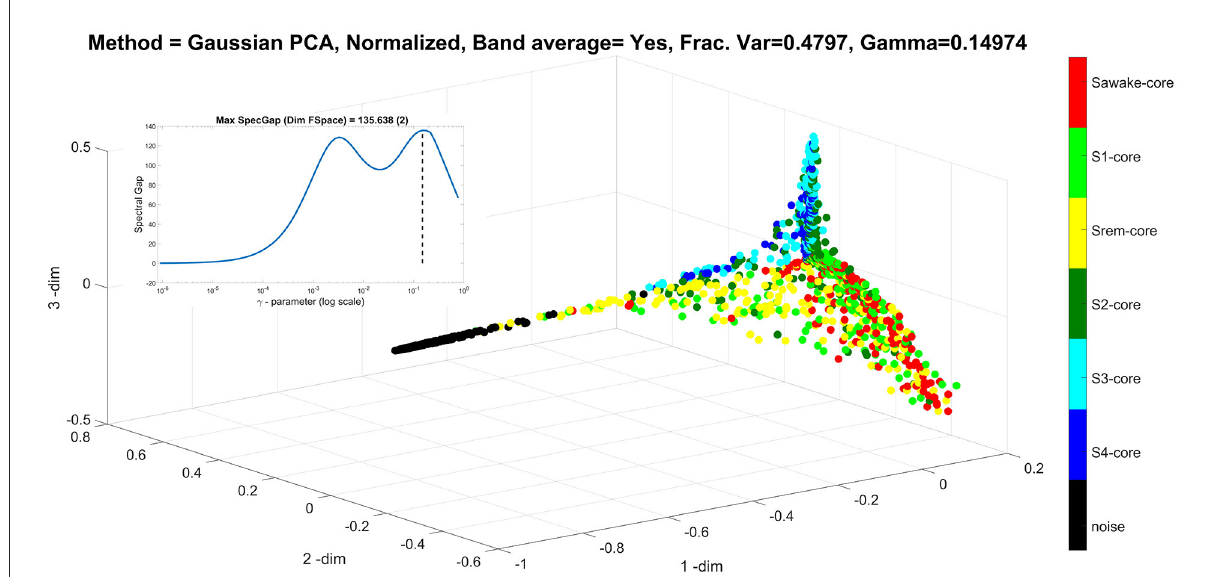
FIGURE6 It is same as Figure 5, but for the value of γ at the second peak, marked by the dash vertical line in the insert (at γ = 0.1497). With this choice of γ , the ellipsoid is lost because the non-linear mapping emphasizes on the distribution of the nodes representing the low amplitude noise. In this case, the method selects the null (noise) direction of the data to be the first principal direction (the most important direction), while the remaining of the data are distributed along the second and third principal direction representing the amplitude of the deep and light sleep. The ellipsoid is lost because the non-linear representation emphasizes the representation of the nodes representing the low amplitude noise in the principal direction constraining the nodes representing the real data on the 2D plane of the second and third principal directions, thus projecting the ellipsoid onto a